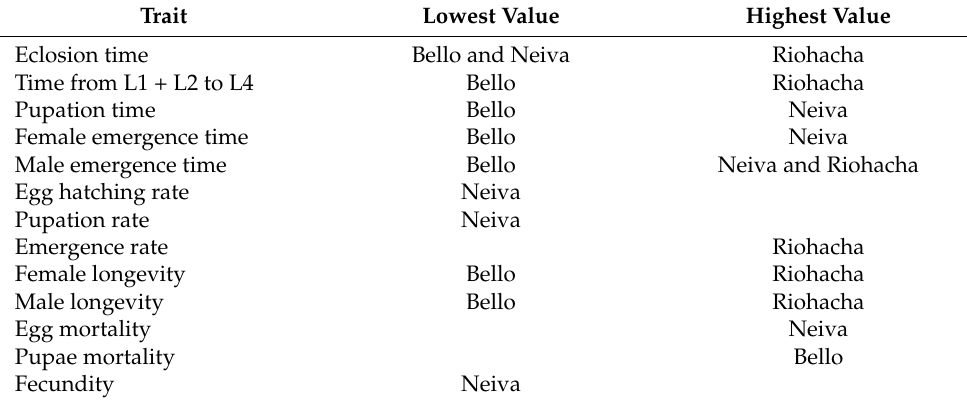
Table 1. Summary of the results from four populations reared at 28 ± 1 ◦ C temperature, 80 ± 5% relative humidity, and 12 h light: 12 h dark photoperiod. For each trait, only populations with extreme values that are significantly different are